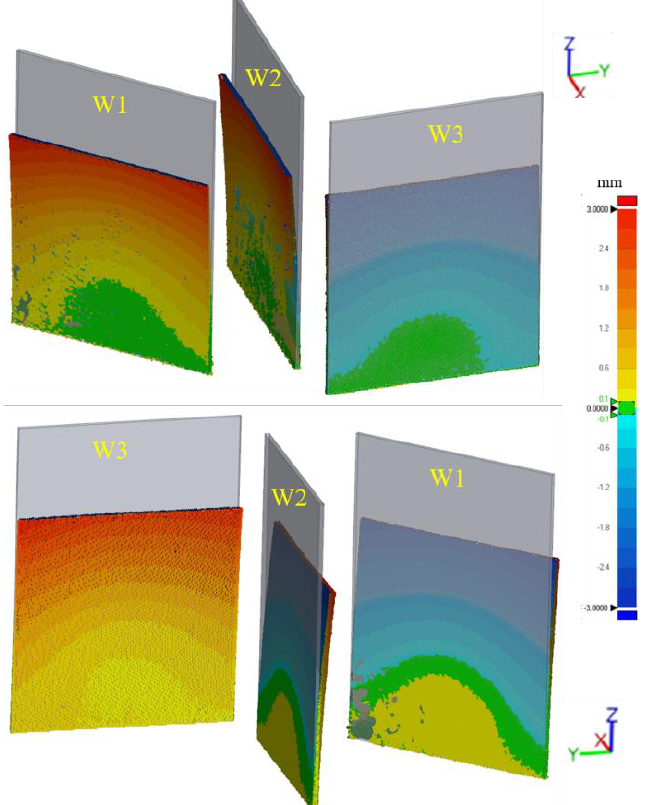
Figure 5. Comparison between the unfinished single − wall parts and the corresponding nominal CAD (grey) geometries.